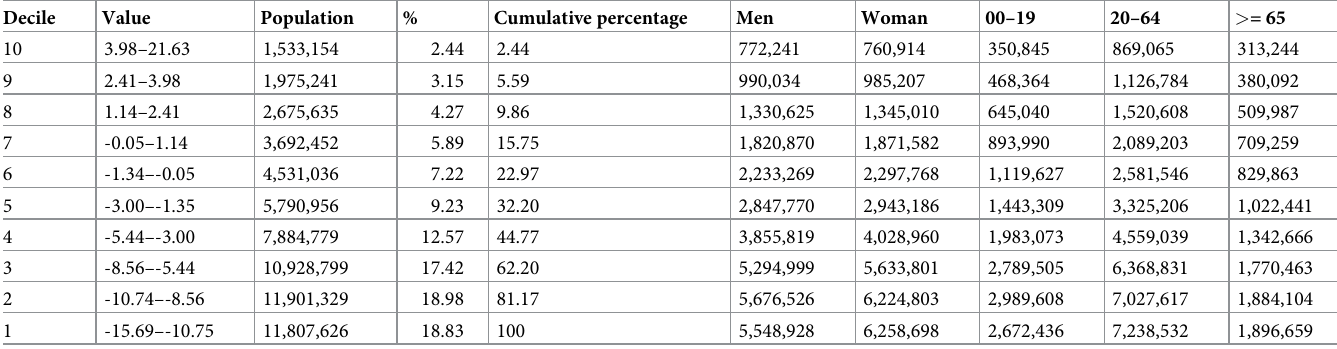
Table 2. Distribution of health accessibility index at IRIS level in metropolitan